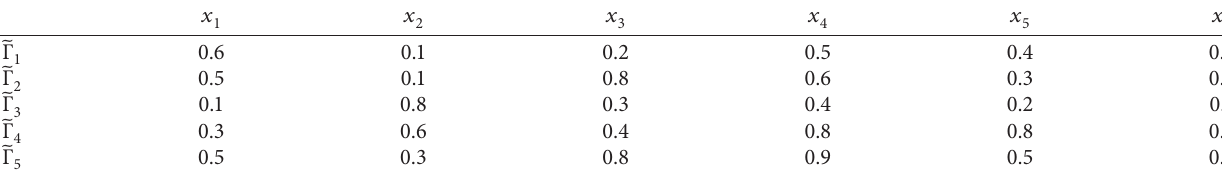
􏽧 M D β i � 1 , 2 , 3 , 4 , 5 , 6. x i for